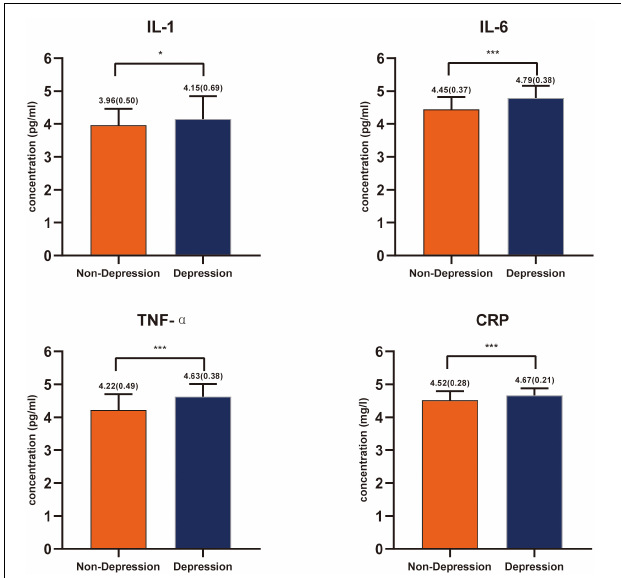
FIGURE 1 | Inflammatory cytokines levels’ comparison between the non-depressed group and the depressed group in patients with glioma expressed with mean and standard deviation. * P < 0.05, *** P < 0.001.